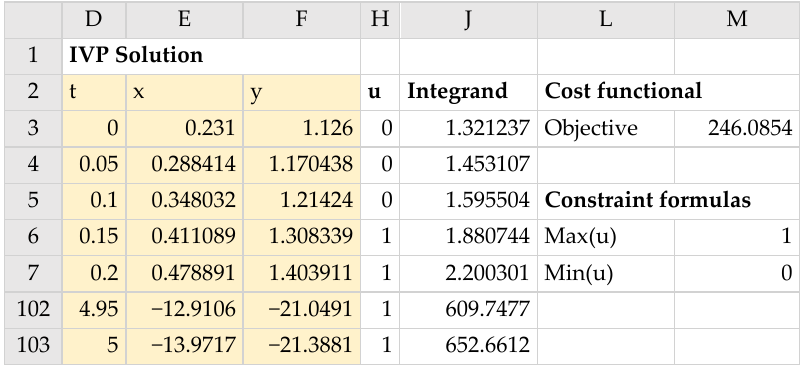
Figure 4. Partial listing of computed results by Formula (11). Also shown are generated control and integrand columns, and initial objective formula value. The associated formulas are listed in Table 1.